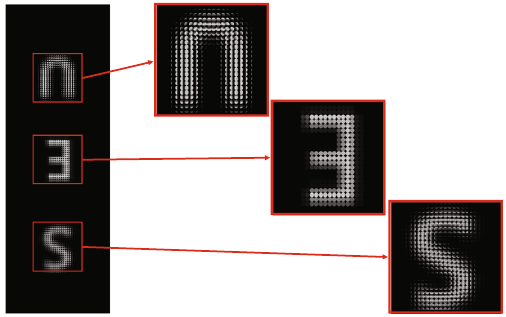
Figure 4: The raw light fi eld image of the point light source array.